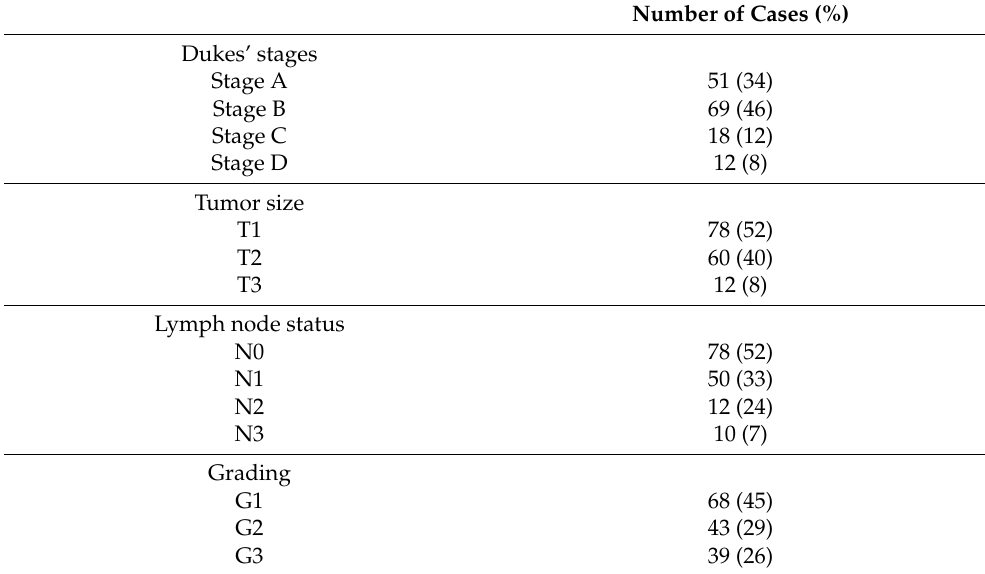
Table 1. Histopathological characteristics of colorectal cancer patients.